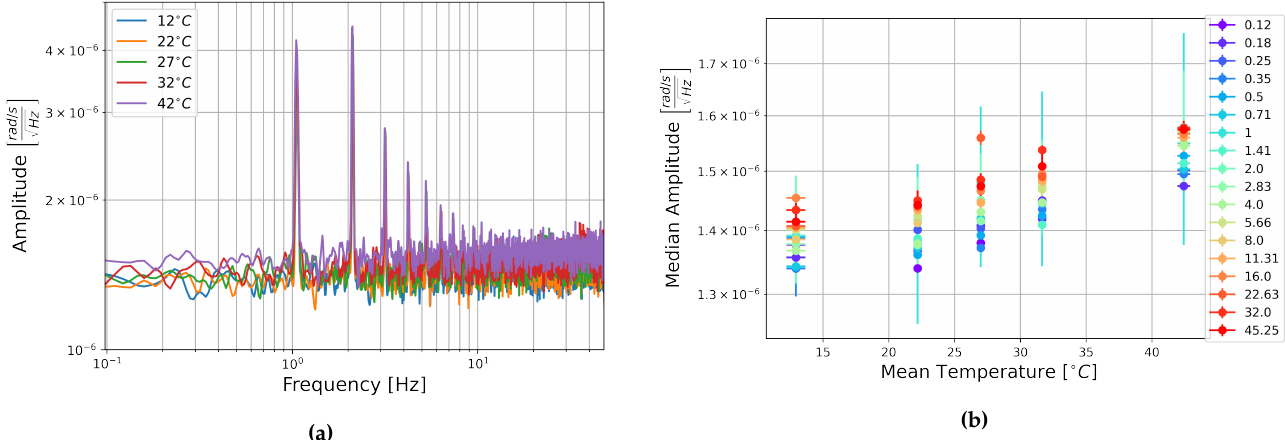
Figure 12. ( a ) Square root of the PSD of component HJZ at each temperature step and ( b ) Median amplitude of the PSD per half-octave as a function of temperature. Vertical error bars show STD of amplitudes, and horizontal bars show STD of temperature